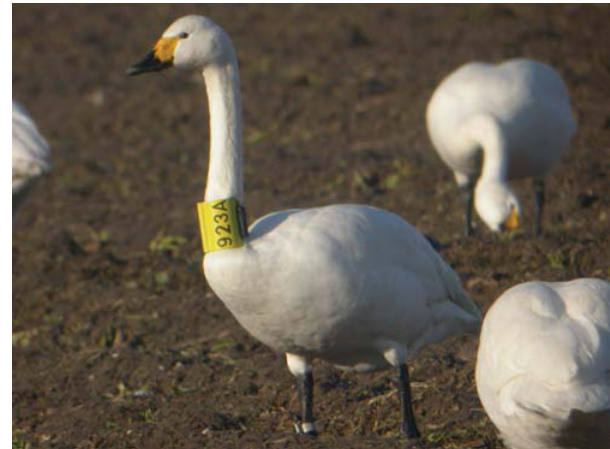
Figure 1. Bewick’s swan 923A infected with an H6 influenza A virus. This (adult) individual not only carried an active influenza infection, it also showed the highest antibody response among all 25 sampled birds. Photo by W.